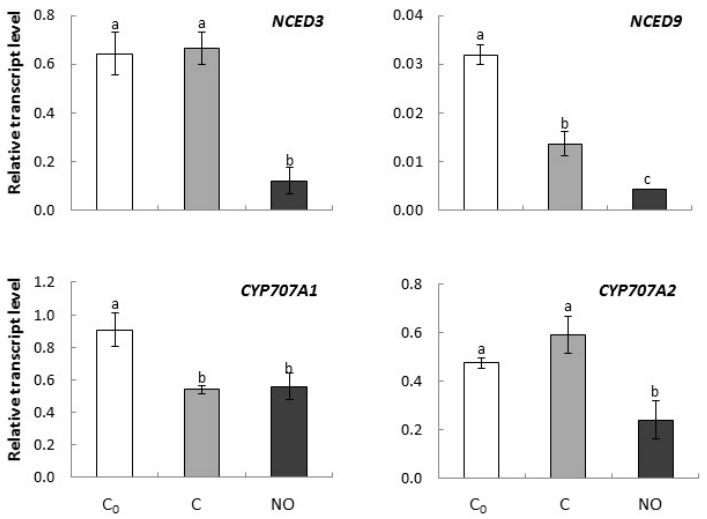
Figure 1. The relative expression level of genes encoding enzymes of ABA biosynthesis ( NCED3 , NCED9 ) and genes encoding enzymes of ABA catabolism ( CYP707A1 , CYP707A2 ) in axes of apple embryos isolated after 24 h of seeds imbibition in water (C 0 ), in axes of embryos imbibed in water for 3 h after seed coat removal (C), in axes of embryos fumigated with NO for 3 h (NO). The expression of genes was normalized to UBI as a reference gene. Two technical replicates were performed for each of four biological replicates. Error bars represent ± SD, a–c homogenous groups.